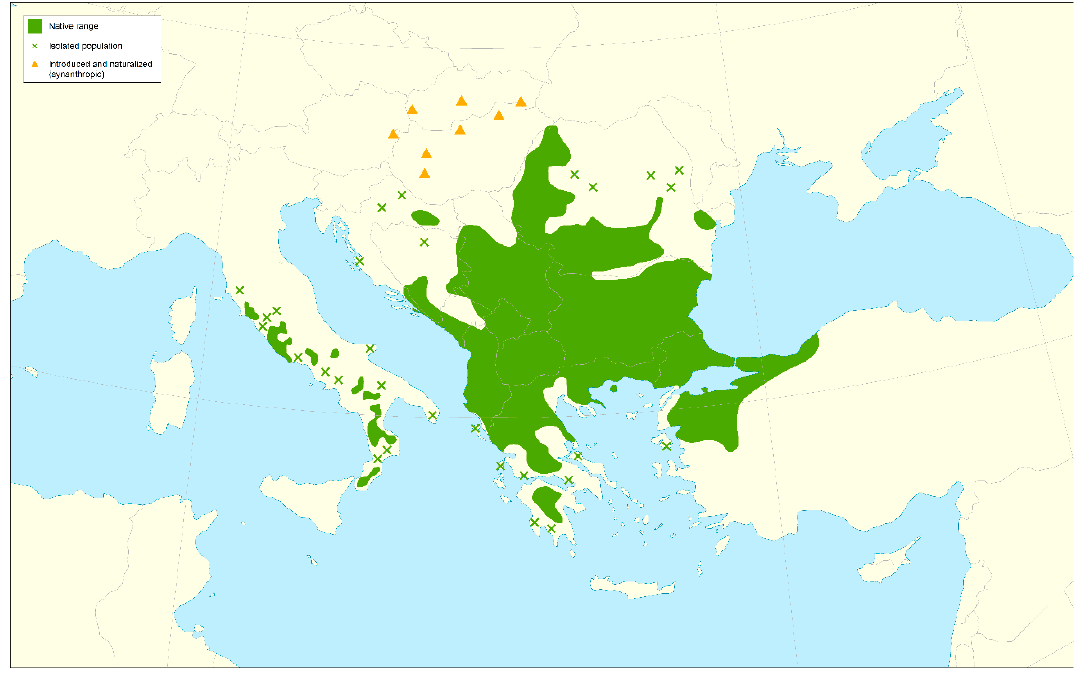
Figure 3. Quercus frainetto Ten. distribution map [62]. https://commons.wikimedia.org/wiki/File:Quercus_frainetto_range.svg